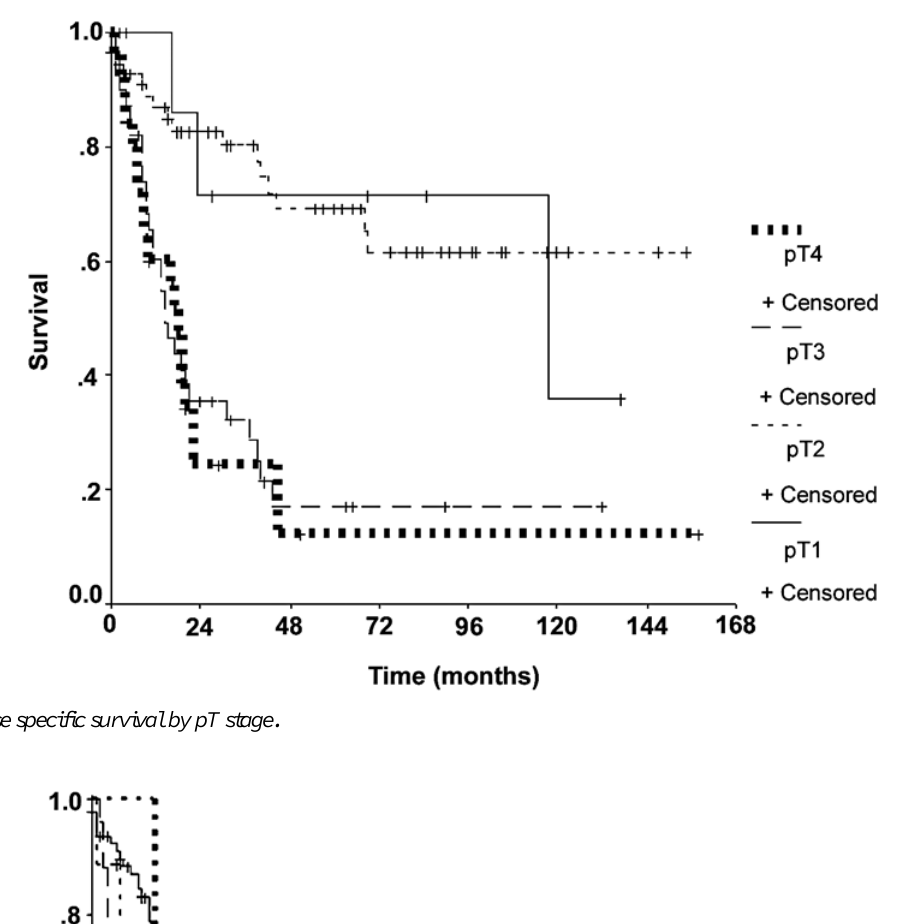
Figure 2 – Disease specific survival by pT stage.